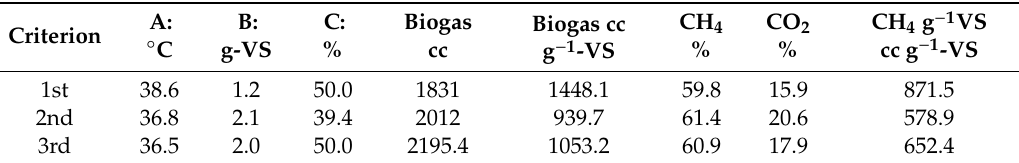
Table 12. The optimal results of the three criteria.